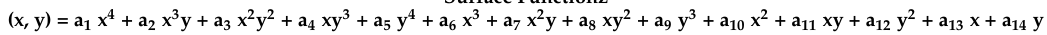
Table 3. Function of the fitted point clouds as well as the RMS and mean errors showing the accuracy of the fit.